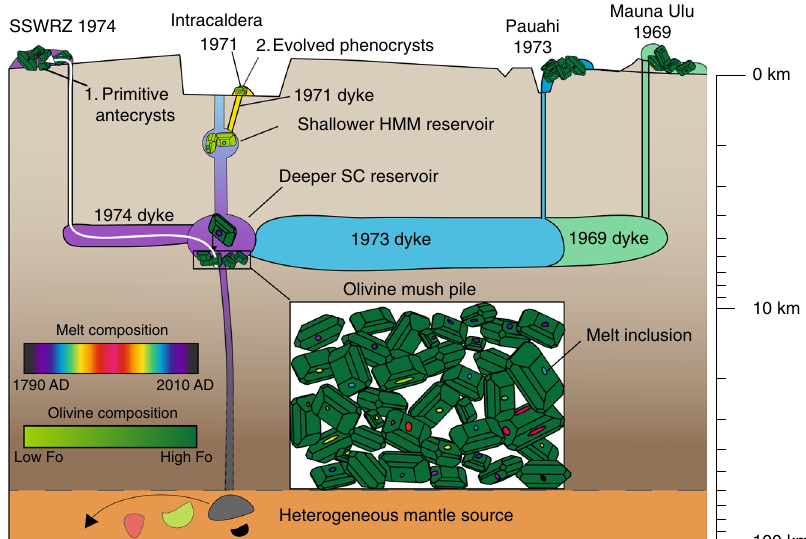
Fig. 5 K ī lauea ’ s upper and lower reservoir contain distinct populations of olivines, with corresponding variations in melt inclusion diversity. Diverse melt compositions are produced by a heterogenous mantle source (indicated on this diagram by the different coloured blobs in the mantle producing chemically diverse melts feeding K ī lauea ’ s plumbing system; refs. 26,27,35,36 ). Mixing processes on ascent and during reservoir replenishment produce a near homogeneous reservoir composition which changes progressively with time (black – red – black over ~200 yrs, Fig. 2a). At a given time, relatively homogeneous reservoir compositions produce melt inclusions with a narrow range of trace element compositions. Olivines (containing melt inclusions) settle to form extensive mush piles at the base of the deeper, SC reservoir (ref. 67 ). Rift zone and extracaldera eruptions are supplied by dykes propagating from the SC reservoir. These erupted liquids scavenge antecrysts from mush piles just prior to eruption, and acquire a melt inclusion record which sampled changing reservoir compositions over centuries to millennia, hosted in a chemically unrelated carrier liquid ( 1 ). In contrast, intracaldera eruptions (e.g., August 1971) are supplied by dykes propagating from the upper HMM reservoir (refs. 26,27 ). These dykes transport phenocrystic olivines to the surface along with the carrier melts in which these olivines crystallised ( 2 ). Magma transport to each eruption site is shown as a dyke tapping the composition of the reservoir at that point in time (after ref. 27 ). Note that the vertical scale is